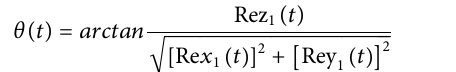
Frontiers in Earth Science |